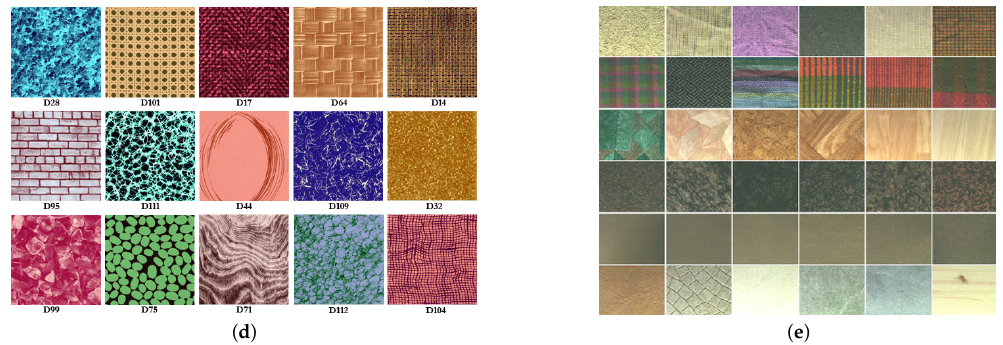
Figure 4. Five image databases used in the experimental study. ( a ) Vistex-640 [37]; ( b ) Stex-7616 [44]; ( c ) USPtex-2292 [46]; ( d ) CBT-2800 [45]; ( e ) Outex-1360 [47].